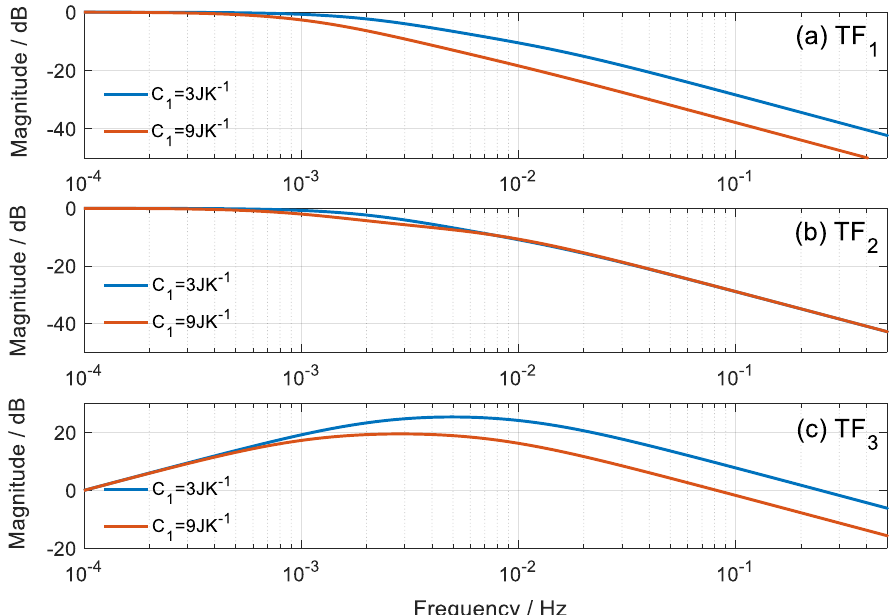
Figure 5. Bode representation of the magnitude of the TF i that relates the calorimetric signal to the inputs of the calorimetric system.